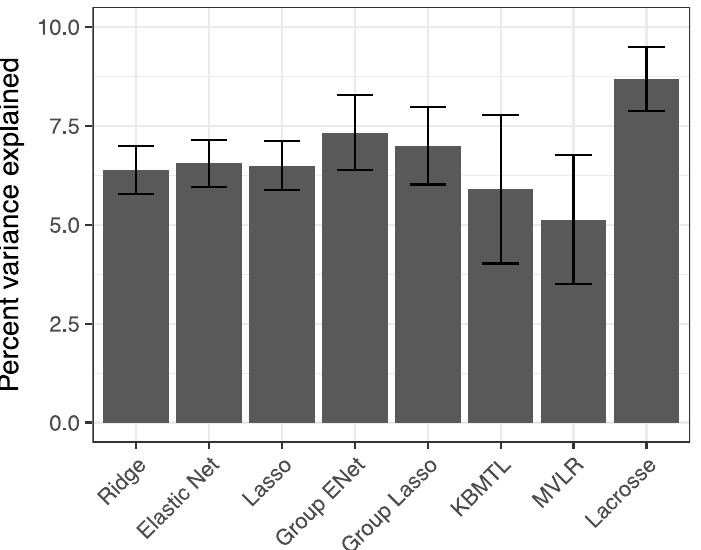
Fig 3. Cross-validated predictive performance on the large CTRPv2 sensitivity screen. Lacrosse significantly outperforms Group Lasso and Elastic Net, which themselves surpass the single task methods as well as KBMTL and